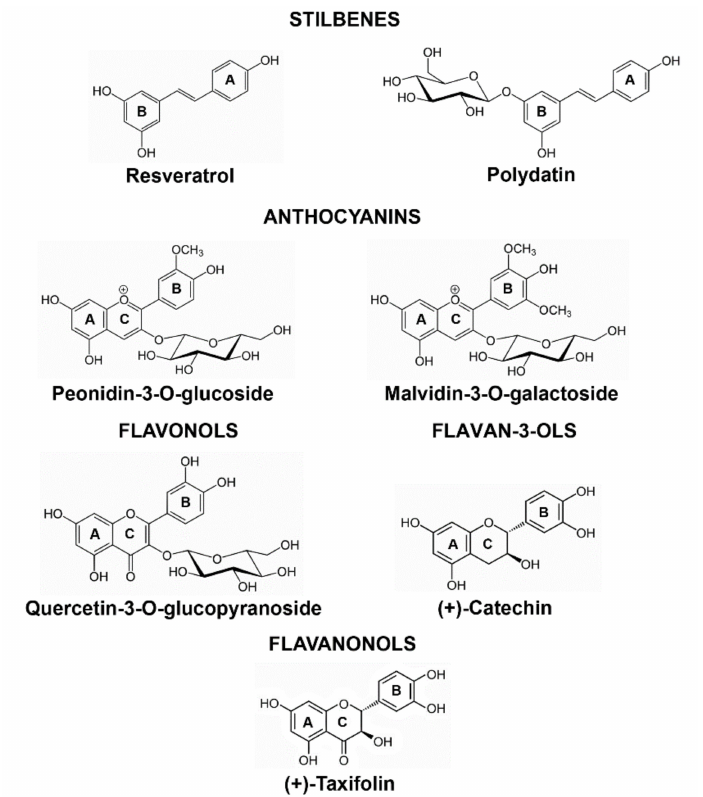
Figure 6. Chemical formulas of the PPs used to study neuroprotection in postnatal